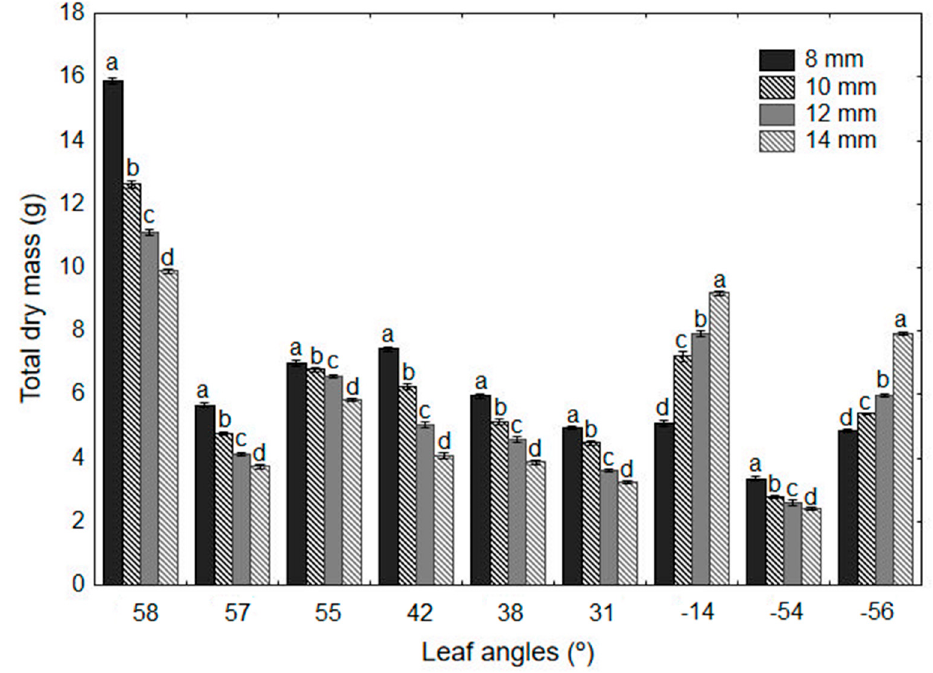
Figure 4. Effect of irrigation volumes for each mean leaf angle on total dry mass (g) of seedlings. For each mean leaf angle, means with the same letter are not significantly different from each other according to Scott–Knott’s test ( p < 0.05). Error bars indicate standard error.